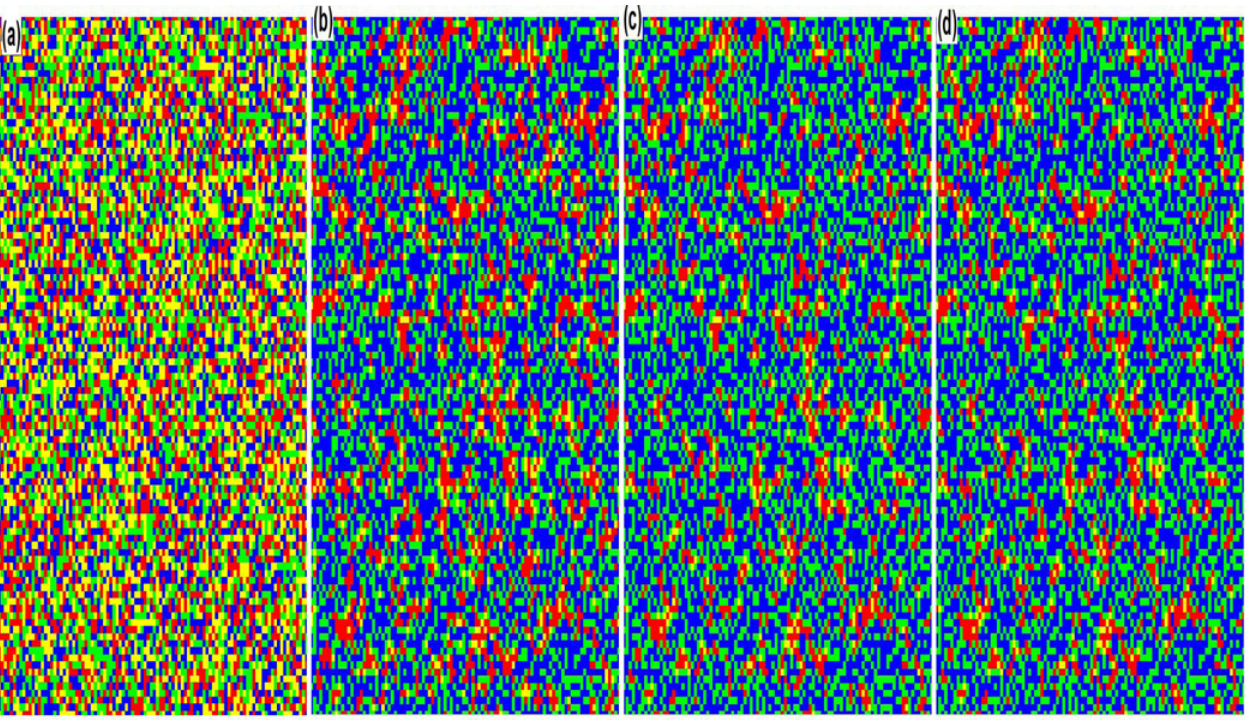
Fig 5. Direct observations of behavioral evolution for the whole population when the values of f and q are 0.5 and 9 respectively. Snapshots are taken at t = 1, 3, 100 and 500 MC steps. The meanings of the four colors are the same with Fig. 2. Specifically, the payoff values are set as [ B 1 , B 2 , B 3 , B 4 , C 1 , C C C 2 , 3 , 4 ] = [2, 2, -1, -1, 1, 1/9, 2, 2/9] in the numerical